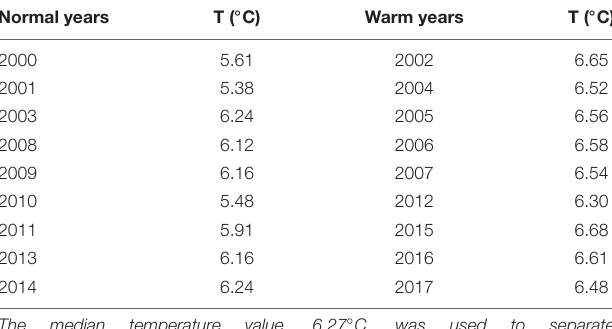
TABLE 1 | Mean yearly temperature (T) in the main distribution area of cod larvae (the polygon in Figure 1 ) from March until August in the upper 50 m in the water